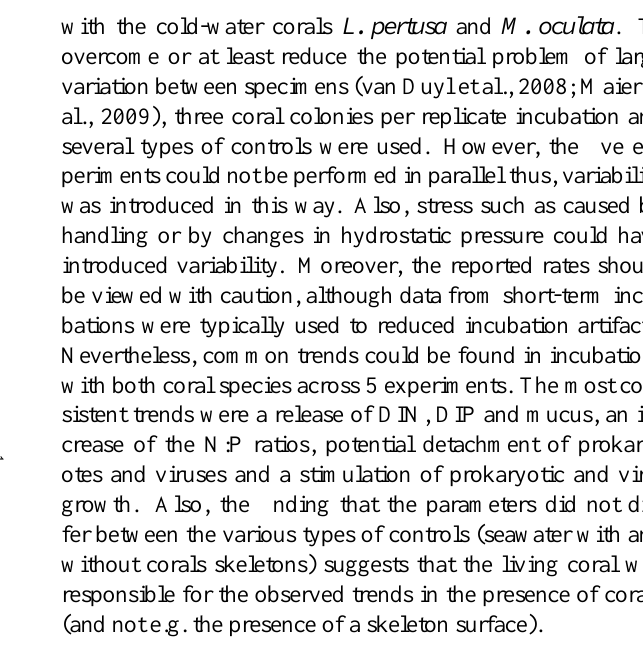
water of the controls of experiment PE decreased, whereas viral abundance increased or remained constant in incubation water with corals; between T2h and T11h, values were for all time points significantly higher for L. pertusa and M. oculata than in the controls (Mann-Whitney, p < 0 . 05; Fig.